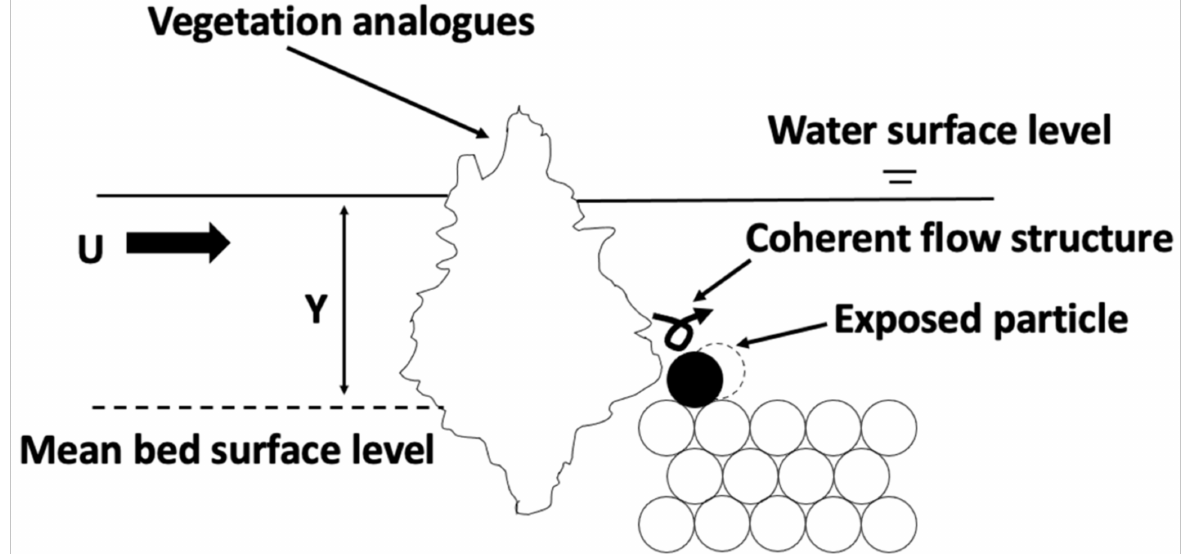
Figure 1. Sketch of the physical processes leading to the destabilization of the riverbed surface downstream of the instream vegetation, in an open channel flow (with mean flow velocity U and depth Y); the exposed particle (black closed circle) resting on the riverbed surface, is swept away (dashed open circle) by a coherent flow